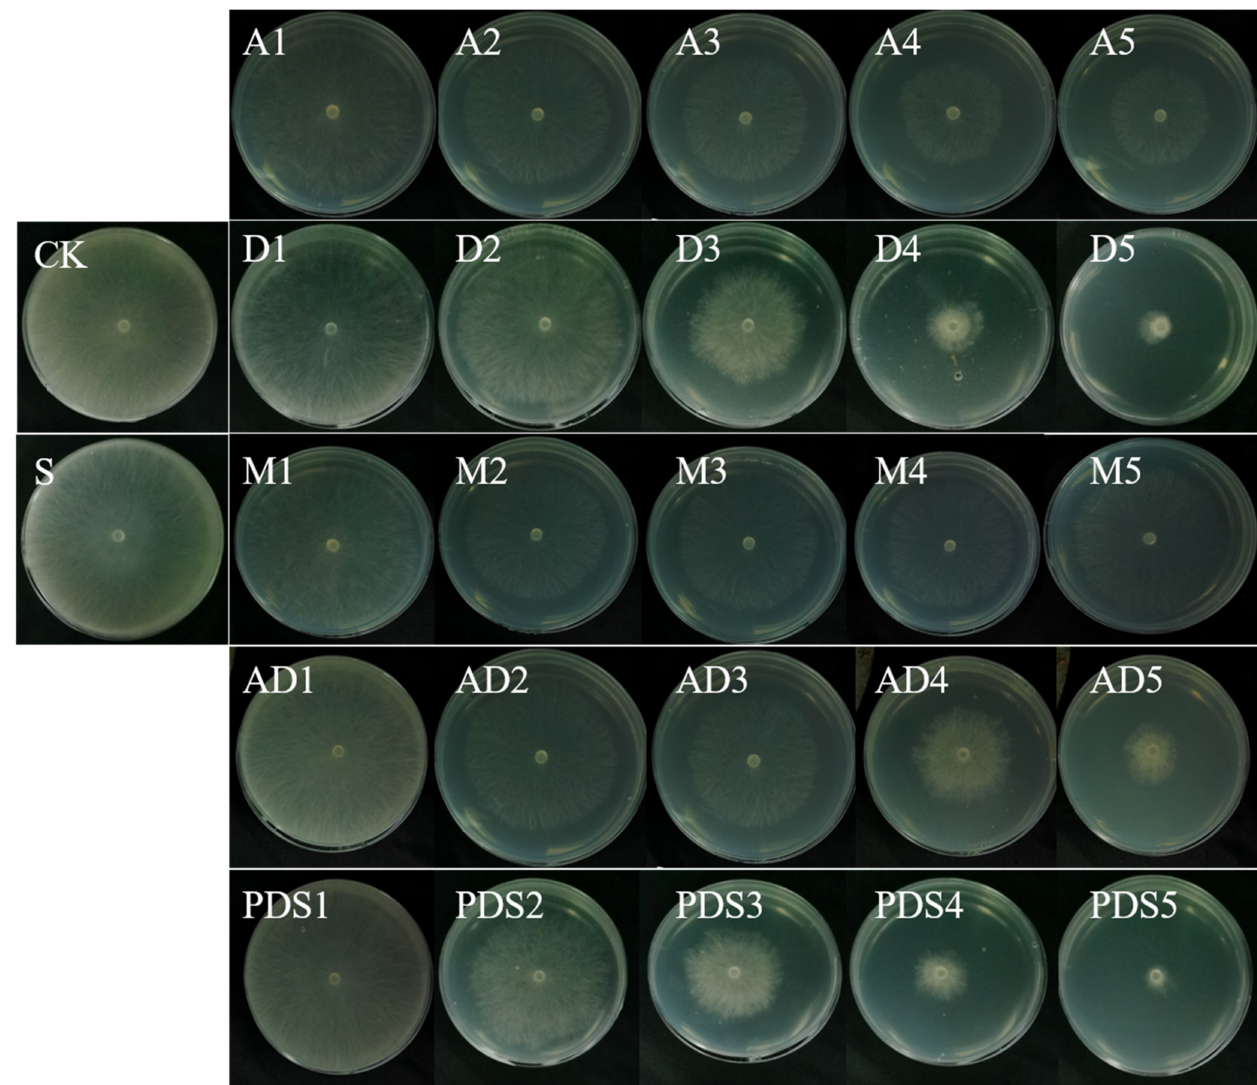
Figure 8. Images of the fungicidal activities of the control without solvent (CK), solvent (S), pure AZOX (A1~5, 0.007, 0.033, 0.17, 0.83, and 4.14 mg/L), pure Dini (D1~5, 0.0033, 0.017, 0.083, 0.42, and 2.08 mg/L), blank carrier of NH 2 - Al-MIL-101 (M1~5, 31.7, 63.4, 26.7, 253.4, and 506.8 mg/L), AZOX + Dini (AD1~5, 0.005, 0.02, 0.1, 0.5, and 2.5